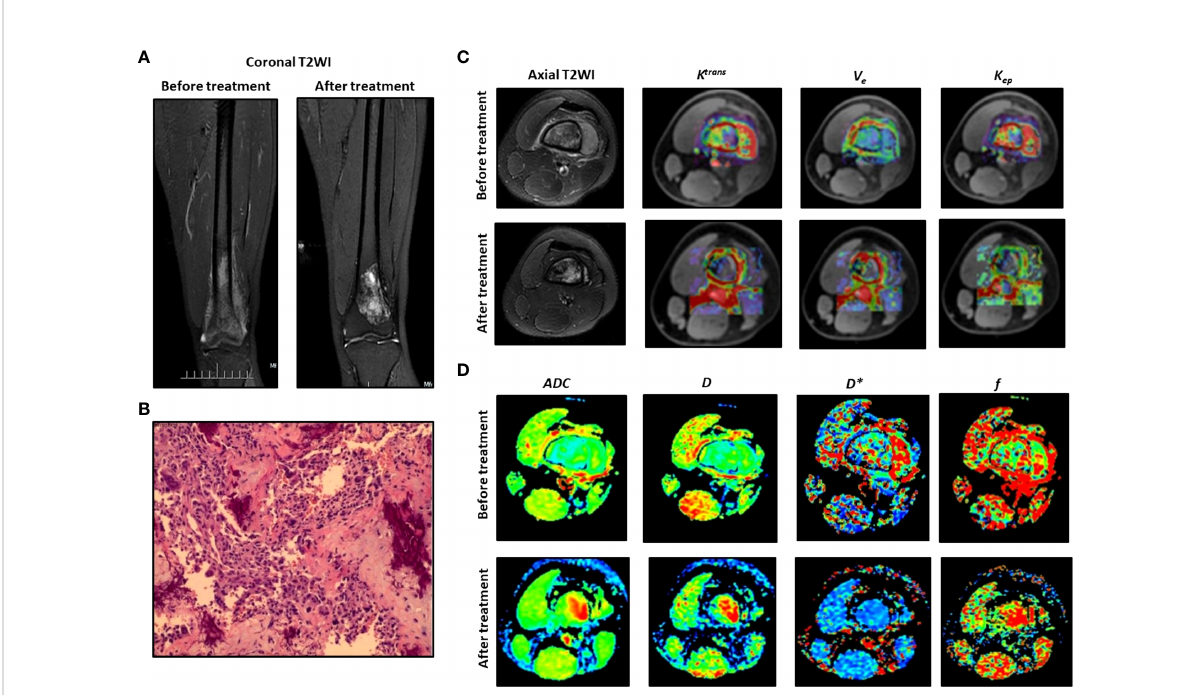
FIGURE 1 Typical DCE-MRI and IVIM-DWI images and the parameters for an 18-year-old male patient. (A) Coronal T2WI before and after treatment. (B) Histological analysis. (C) Axial T2WI and K trans , K ep , V e . (D) Images for D , D* , ADC and